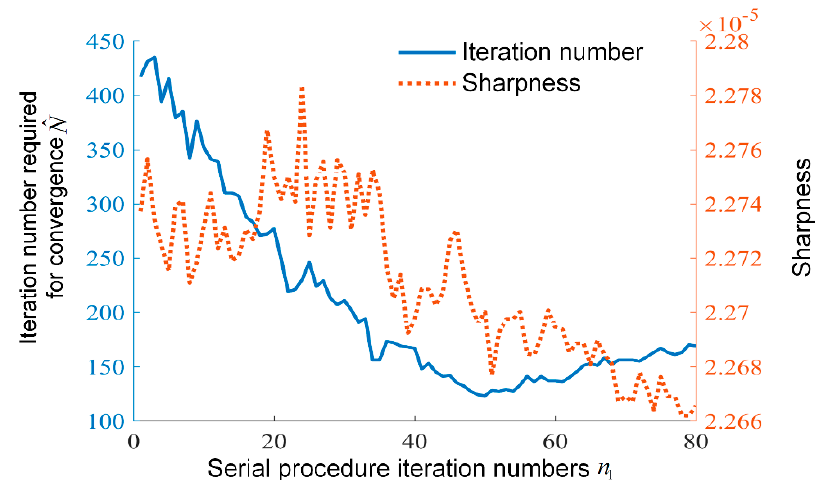
Figure 10. The effect of the serial process iteration number on reconstruction performance of the proposed cascaded method.